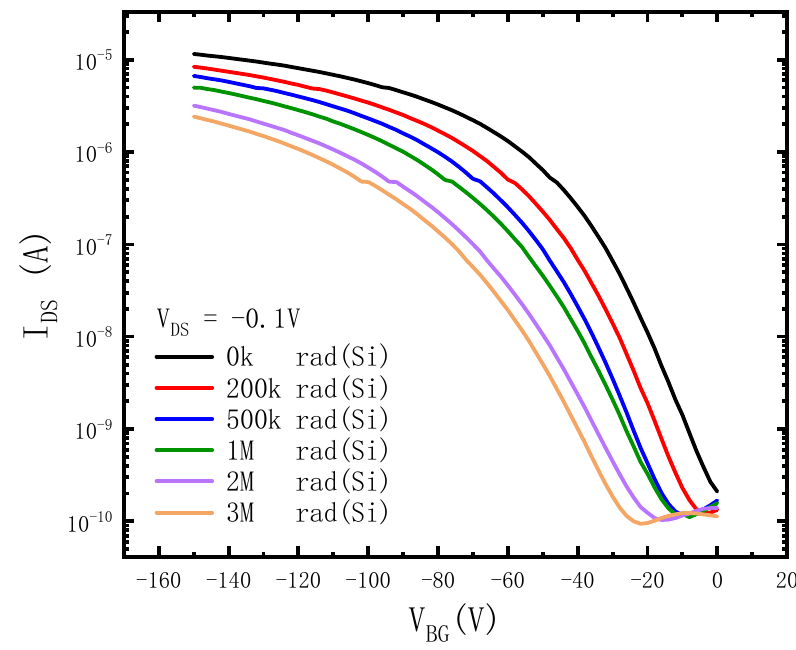
Figure 6. I DS -V BG characteristics of the back-gate after irradiation.